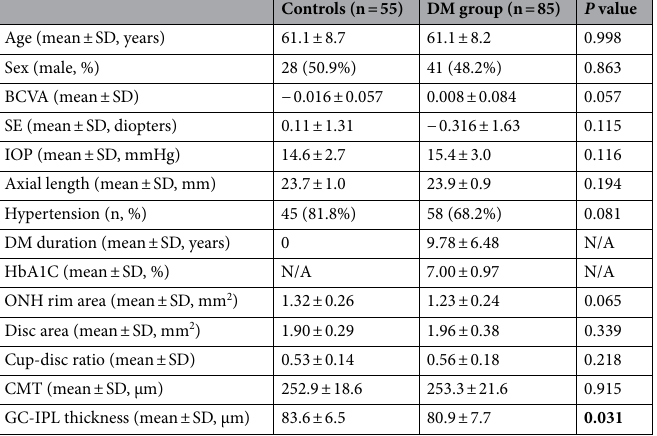
Table 1. Demographics and clinical characteristics. Values in boldface ( P < 0.05) are statistically significant. SD standard deviation, BCVA best-corrected visual acuity, SE spherical equivalent, IOP intraocular pressure, DM diabetes, ONH optic nerve head, CMT central macular thickness, GC-IPL ganglion cell-inner plexiform